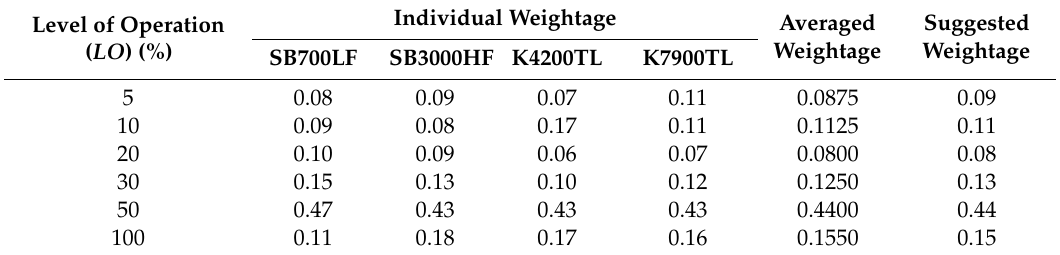
Table 9. Determination of general η EQUA